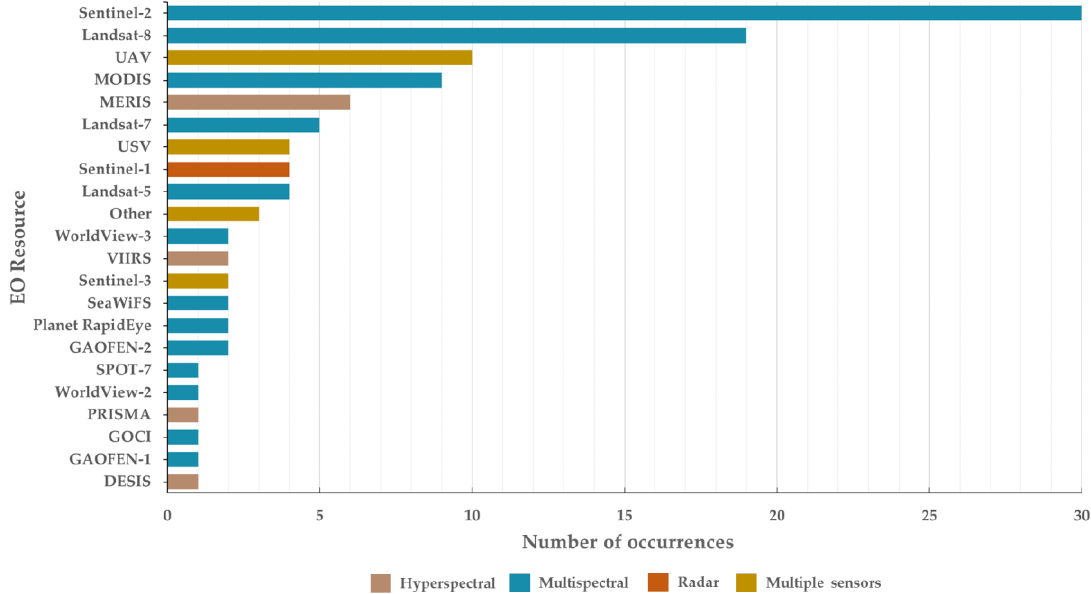
Figure 8. Number of EO resources mentioned in the studies under examination. Other includes two works related to airborne flights and one with in situ spectra fixed platform. works related to airborne flights and one with in situ spectra fixed